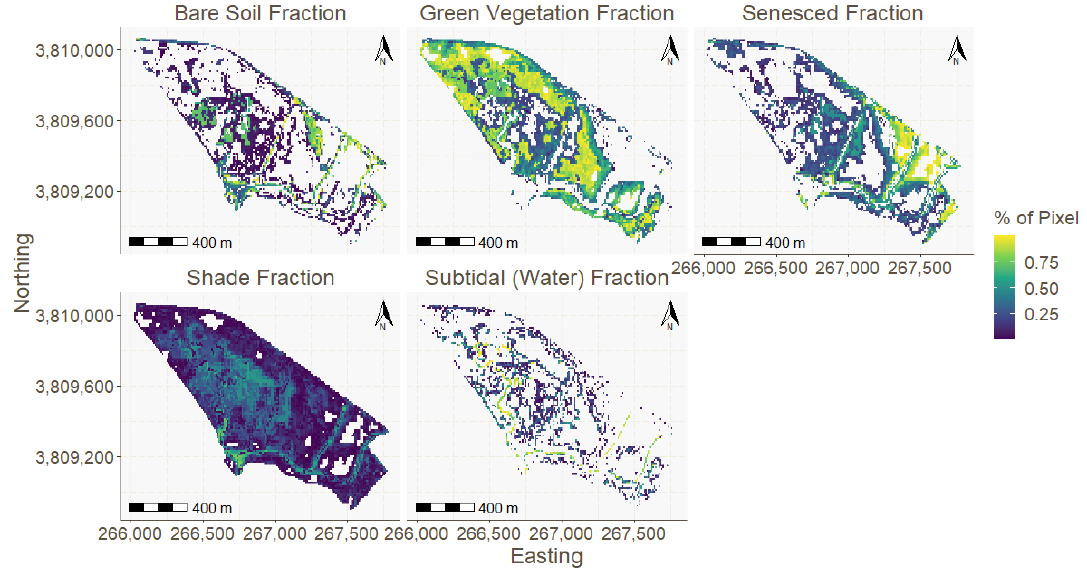
Figure 3. Fractional cover for November 2020 shown as an example of MESMA results. Scale indicates proportion of pixel that is made up of respective endmembers or shade. Pixels with a 0% cover were removed for visual clarity.